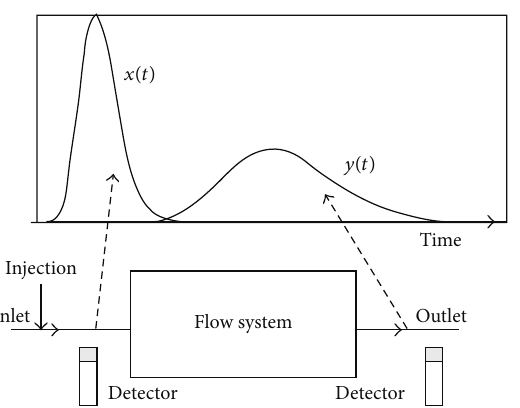
Figure 1: The principle of radiotracer experiment by Furman et al. 2003 [4].